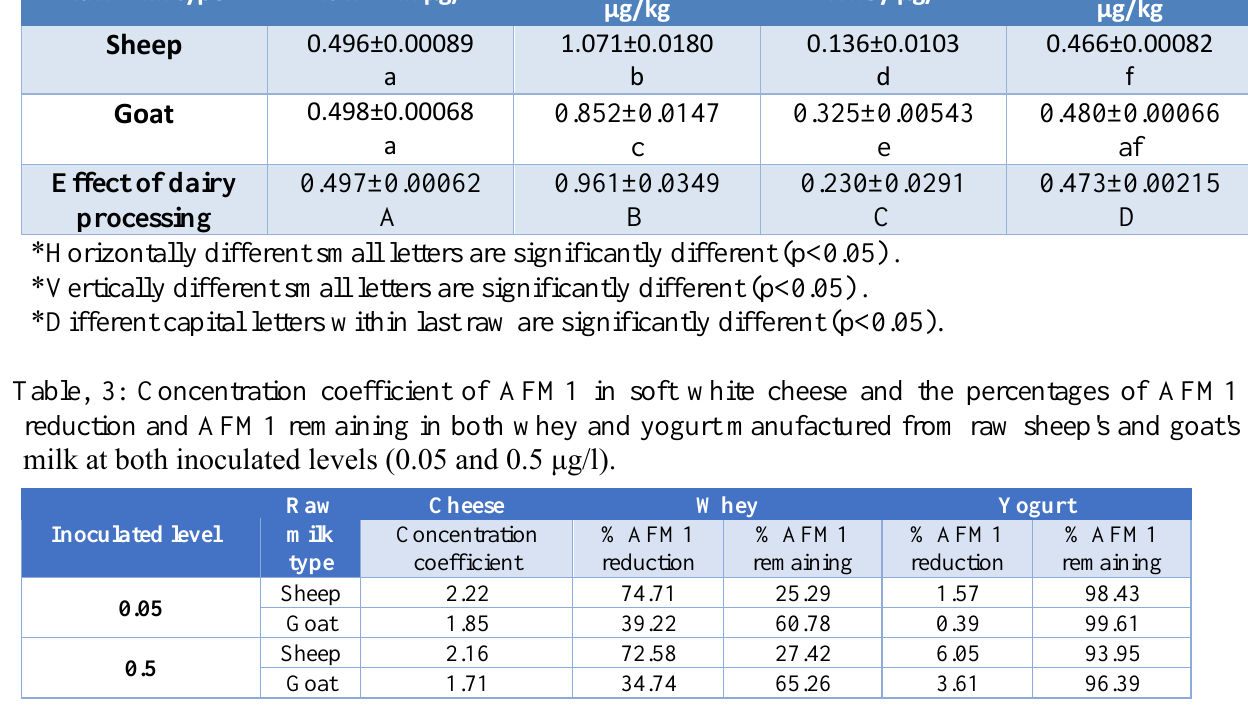
Table, 2: Mean concentration of AFM1 (μg/kg or l) in soft white cheese, whey and yogurt produced from raw sheep's and goat's milk experimentally inoculated with AFM1 at a concentration of 0.5 µg/l. Raw milk type Raw milk μg/l